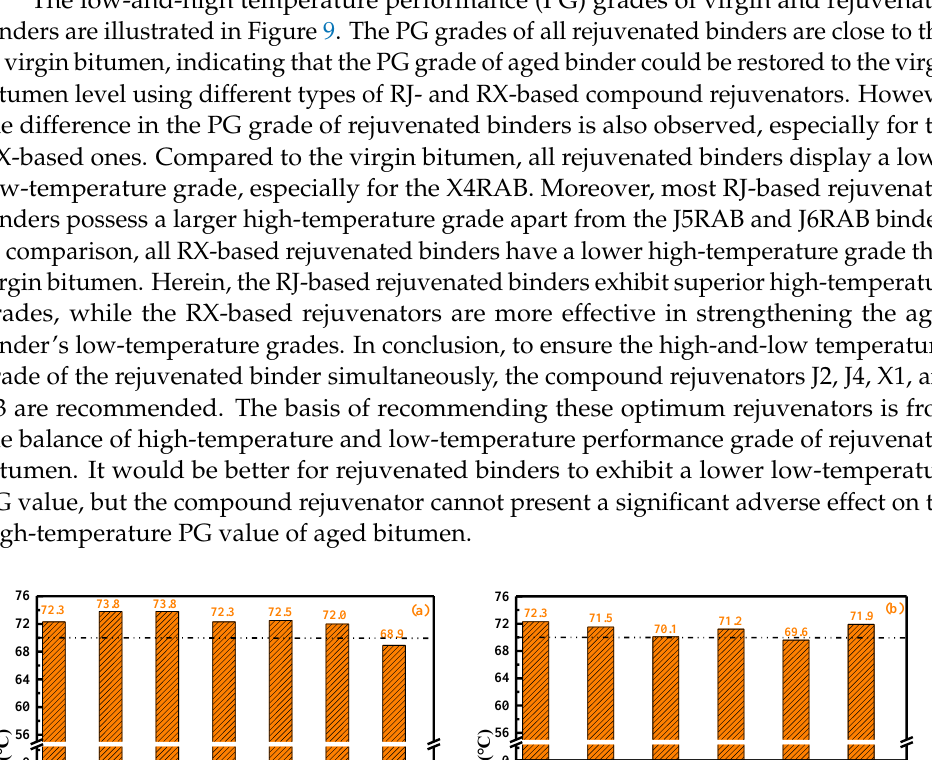
−0.417 Table 10. G 12 parameter of rejuvenated binders with RX-based rejuvenators. Rejuvenated Binders